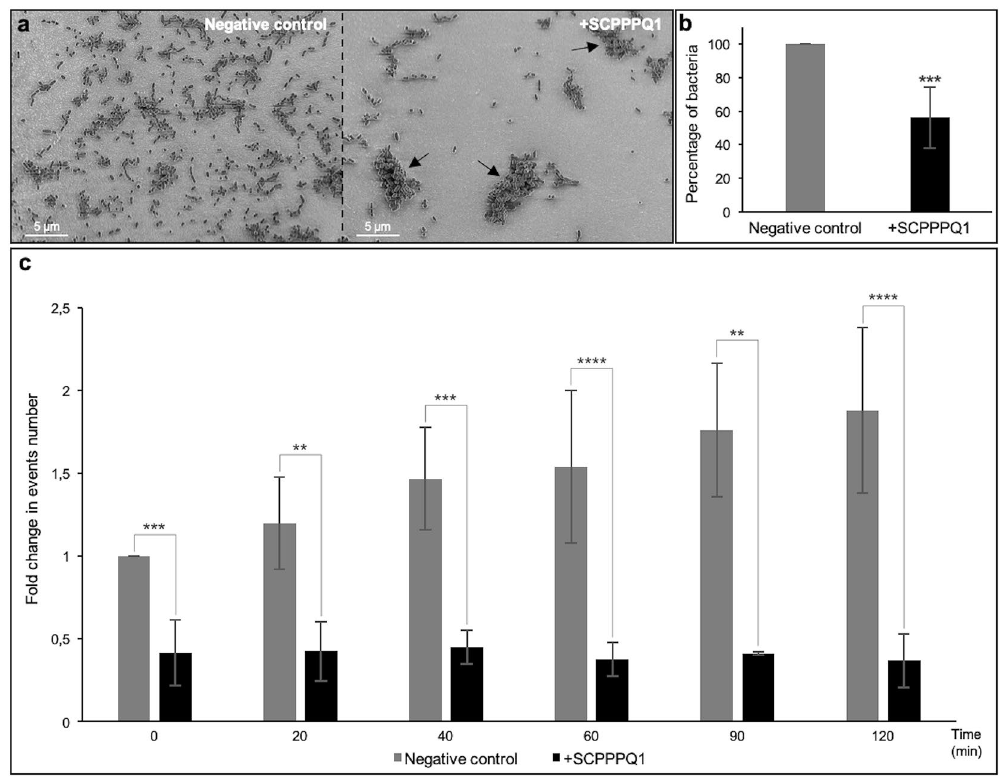
Figure 3. Effect of SCPPPQ1 on P. gingivalis bacterial population size. ( a ) SEM images showing bacteria from the negative control and + SCPPPQ1 treated sample at 20 min. Note the presence of aggregates only in presence of the protein (arrows). Micrographs are representative from five different experiments. ( b ) Quantification of the number of bacteria in percentage observed in SEM images incubated with + SCPPPQ1 normalized on the negative control at 20 min. Data are represented as mean ± standard error of mean ( n = 5). Significance was determined by two-tailed Student’s t test analysis (*** p < 0.001). ( c ) FACS results of fold change in events number over time, in samples treated with negative control or + SCPPPQ1, normalized on the negative control at 0 min. Data are represented as mean ± standard error of mean ( n = 4). Significance was determined by two- tailed Student’s t test analysis (** p < 0.01; *** p < 0.001; **** p <